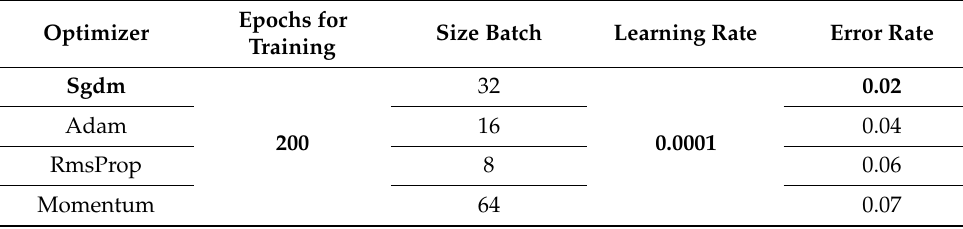
Table 1. Hyperparameters of the proposed segmentation model.